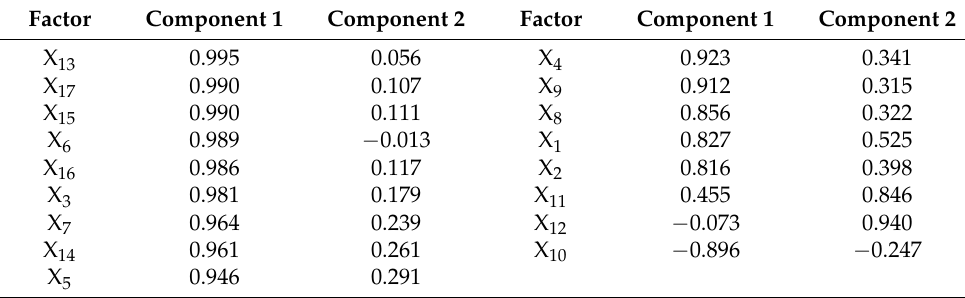
Table 9. Factor load matrix after orthogonal